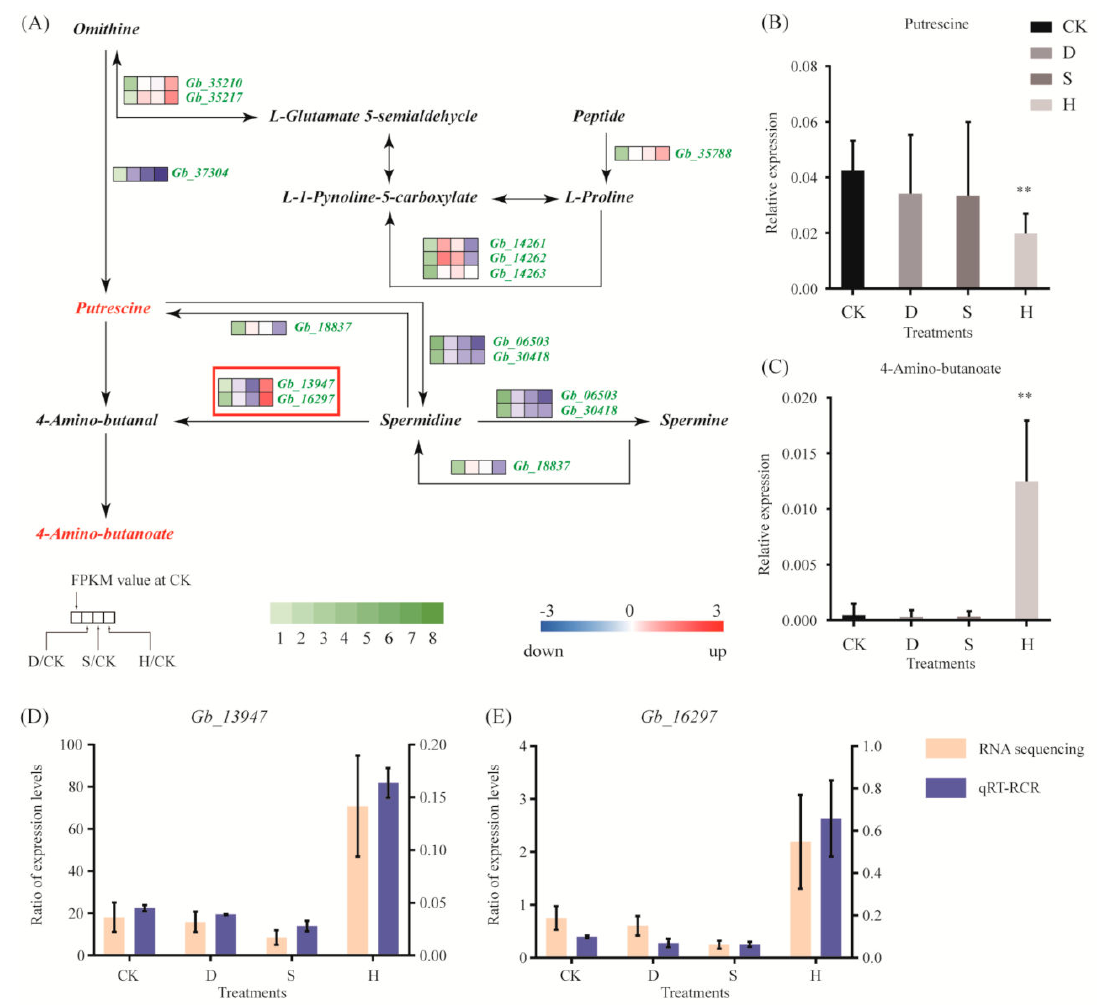
Figure 5. Gene expression and metabolites involved in the arginine and proline metabolic pathways. ( A ) DEGs associated with these pathways. Red and blue indicate upregulation and downregulation, respectively. Red frames indicate the upregulated or downregulated genes discussed in the main text. ( B , C ) Expression of ( B ) putrescine and ( C ) 4-amino-butanoate. Error bars represent the mean ± SD; n = 5; **, p < 0.01, compared with CK. ( D , E ) Expression of ( D ) Gb_13947 and ( E ) Gb_16297 , as determined by qRT-PCR. Error bars represent the mean ± SD; n = 3. CK: Control; D: Drought; S: Salt; H: